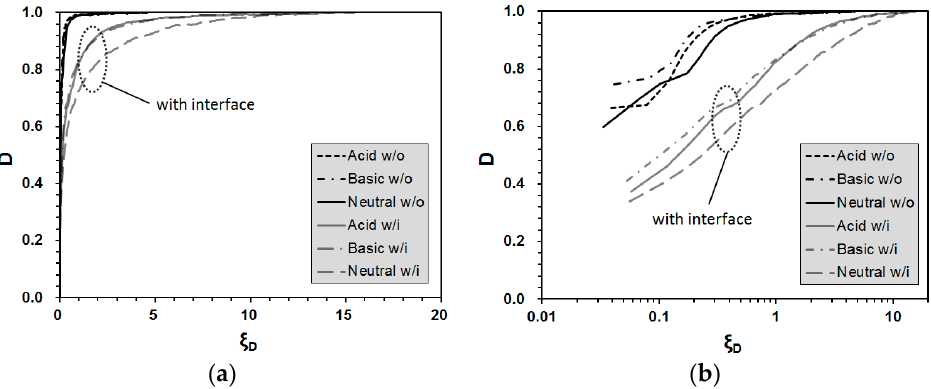
Figure 9. Disturbance function curves for soil alone versus with interface after 850 days submersion, 0.3 MPa: ( a ) natural scale; ( b ) log scale.